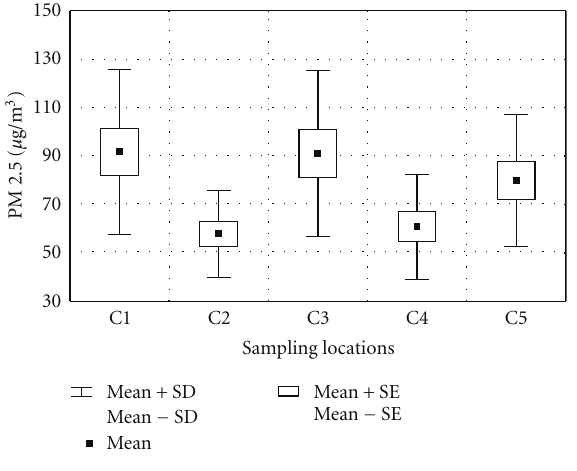
Figure 2: PM 2.5 trends in